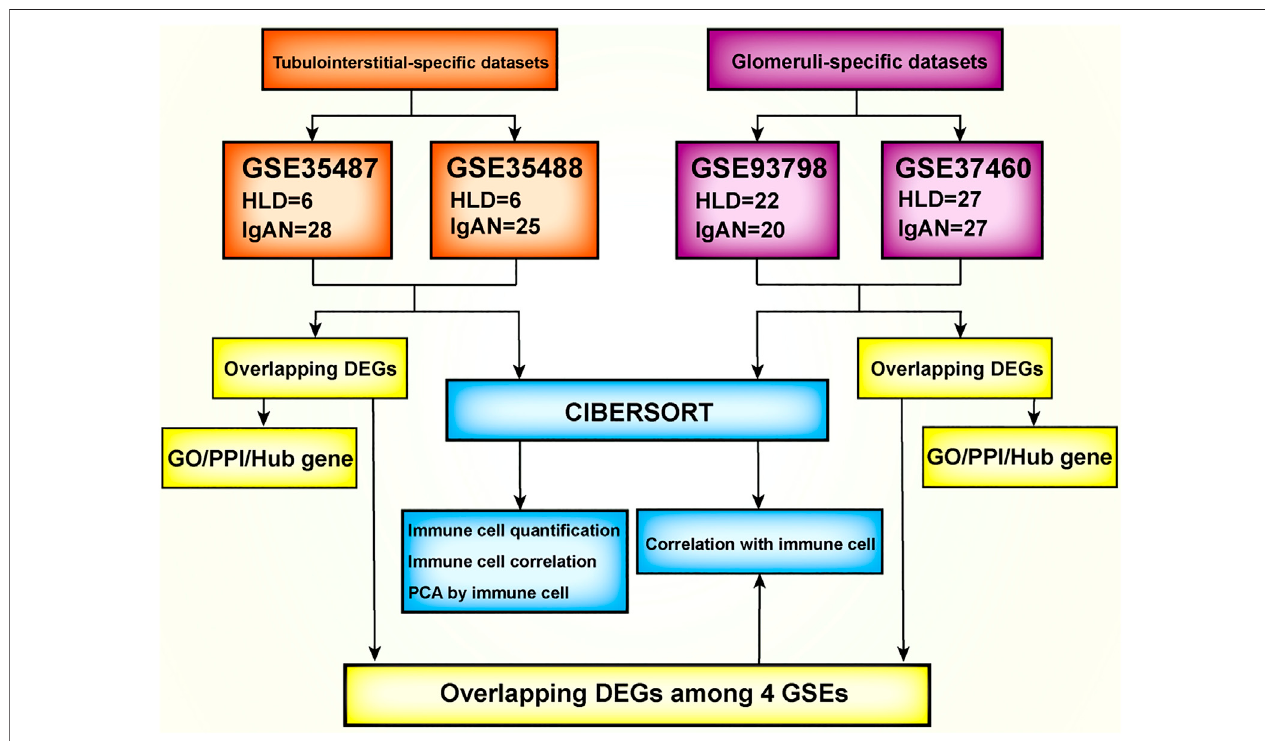
FIGURE 1 | Flowchart of the analysis used in this study. GSE, gene expression data series; DEG, differentially expression genes; CIBERSORT, Cell-type Identi fi cation By Estimating Relative Subsets Of known RNA Transcripts; GO, Gene Ontology; KEGG, Kyoto Encyclopedia of Genes and Genomes; PCA, principal component